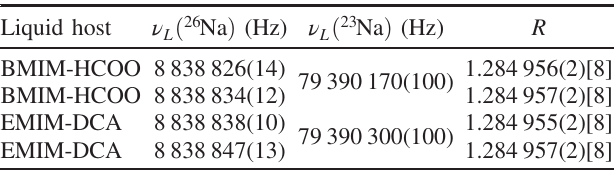
TABLE I. Larmor frequencies of 26 Na at 1.2 T and 23 Na at 7.05 T in BMIM-HCOO and EMIM-DCA, and the resulting ratio of the magnetic moments, R , based on Eq. (3). Errors in round brackets are due to the statistical uncertainties in the resonance frequencies. For R , this error includes only the uncertainty of the 26 Na resonance frequency, while the square brackets are due to other contributions, including the uncertainty of the 23 Na reso- nance